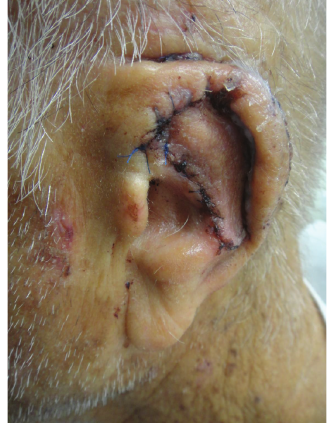
Figure 7: Two-week postoperative